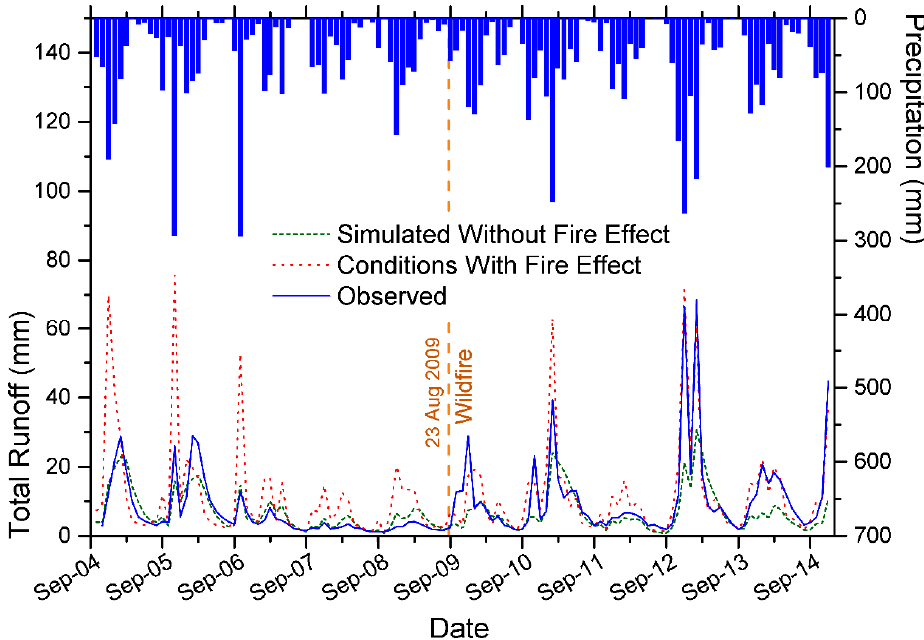
Hydrology 2021 , 8 , x FOR PEER REVIEW 14 of 23